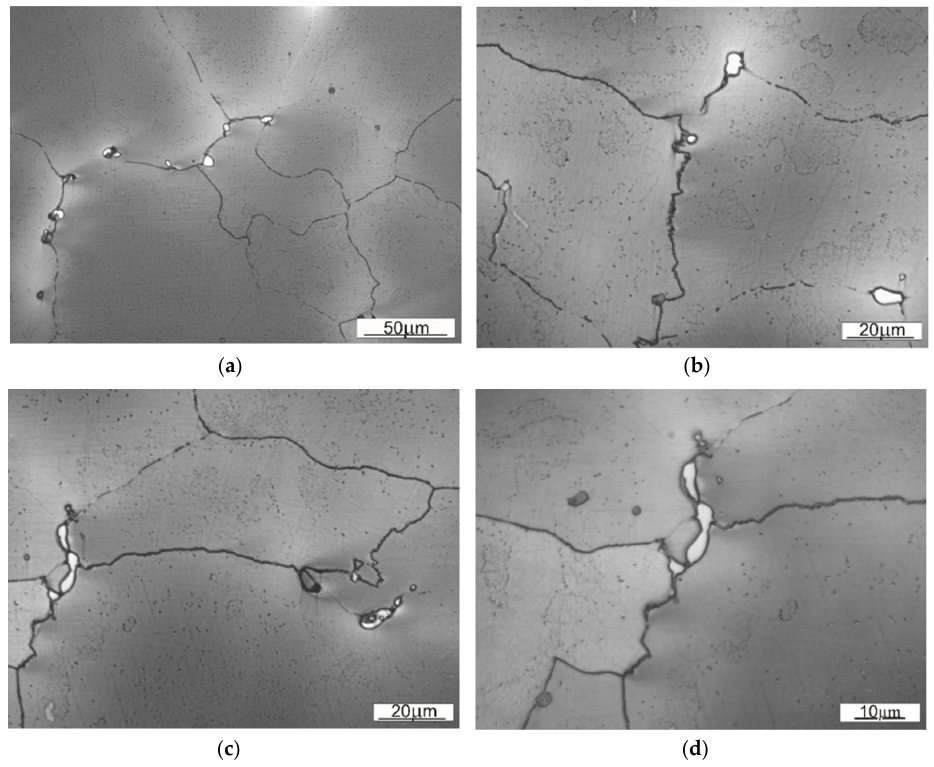
Figure 9. Base material of the sample SS2 with visible carbides and other precipitations. ( a ) 50x magnification, ( b ) 100x magnification, ( c ) 100x magnification, ( d ) 150x magnification. Comparing both samples one can observe that in the case of material used for sample SS1 the precipitations occur inside the austenitic grains, whereas in case of SS2 they tend to occur near the grain boundary. That observation explains the fine-grained structure of SS2, where the precipitations limit or block the growth of crystalline grain. A close-up on the structure located nearby the contact working surface for both types of steel is presented on Figures 10 and 11. As those are the most strained regions of the given Mangalloy steel bodies, expected disloaction twinnings are perceptible. ( a )